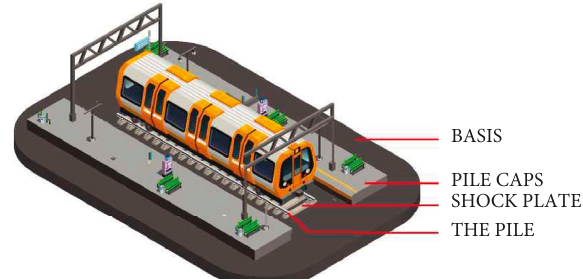
Figure 24: Comparison of horizontal displacement field between numerical simulation and model test of reinforced front antislide piles in the antislide section of bridge